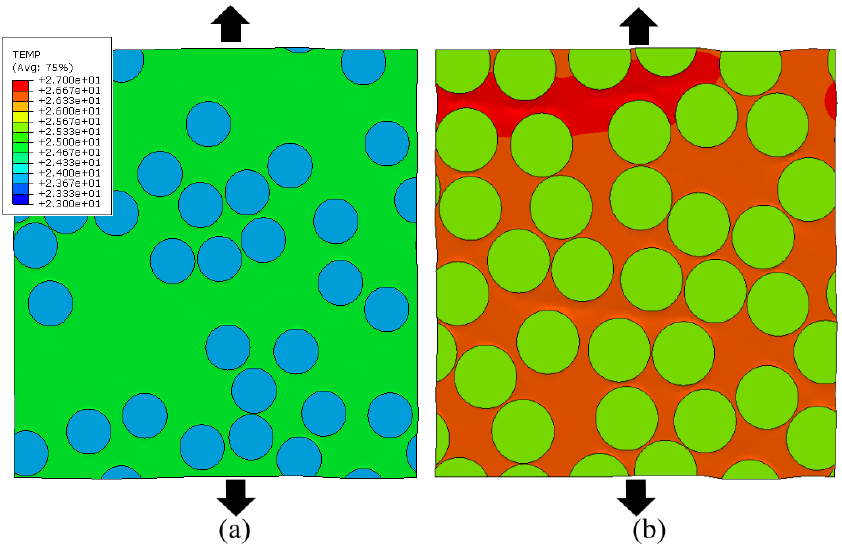
Figure 5. Homogenized stress-strain and temperature-strain with volume fraction.